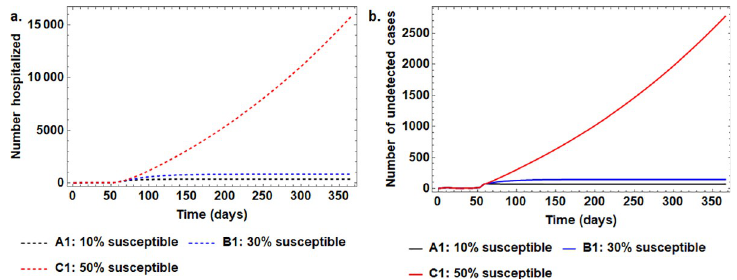
Fig 2. The effect of reducing the proportion of susceptible population after 58 days since the reporting of the first confirmed COVID-19 case in Uganda. Scenario A1 involves maintaining the 10% level while the alternative scenarios investigated are B1 involving 30% and C1 involving 50% of the national population of 43 million being susceptible. The different panels depict the time series variation as Panel (a): the number of hospitalized individuals and Panel (b): the number of undetected infectious individuals that are freely living in the communities. In each scenario, all other parameters are kept at their default values.